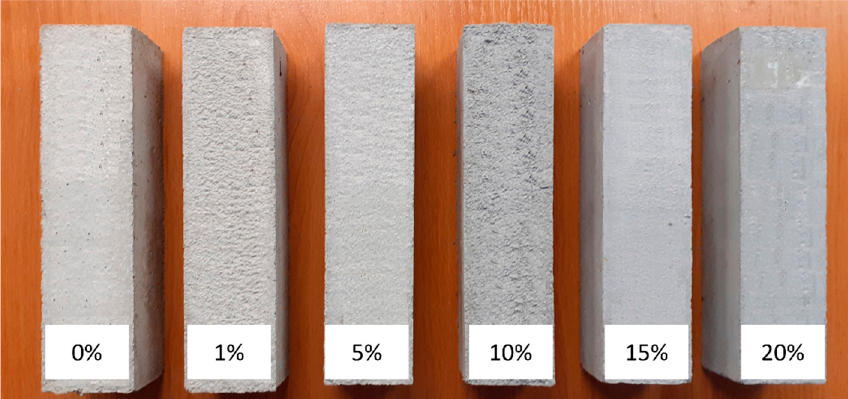
Figure 7. Pictures of concrete beams with the addition of calcite contaminated with waste powder toner (sample A). Table 5. Compressive strength of concrete with the addition of calcite contaminated with waste toner powder.